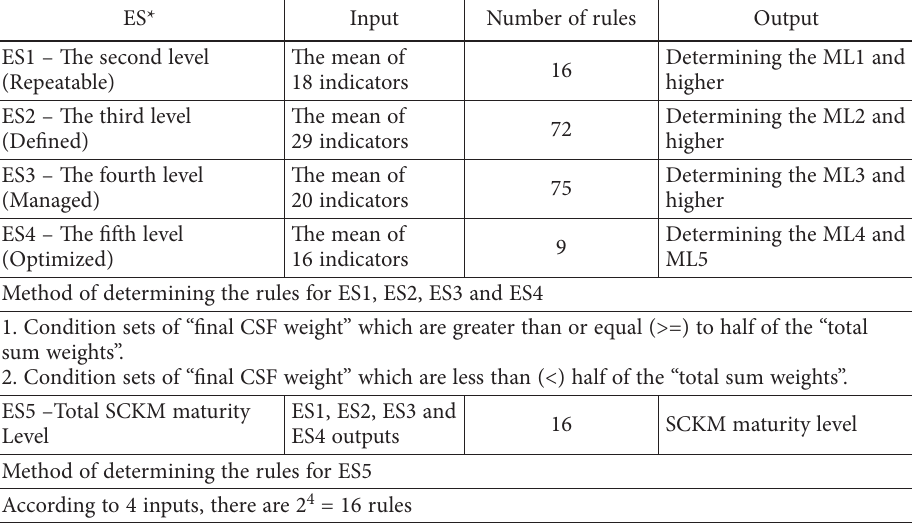
Table 6. The specification of expert